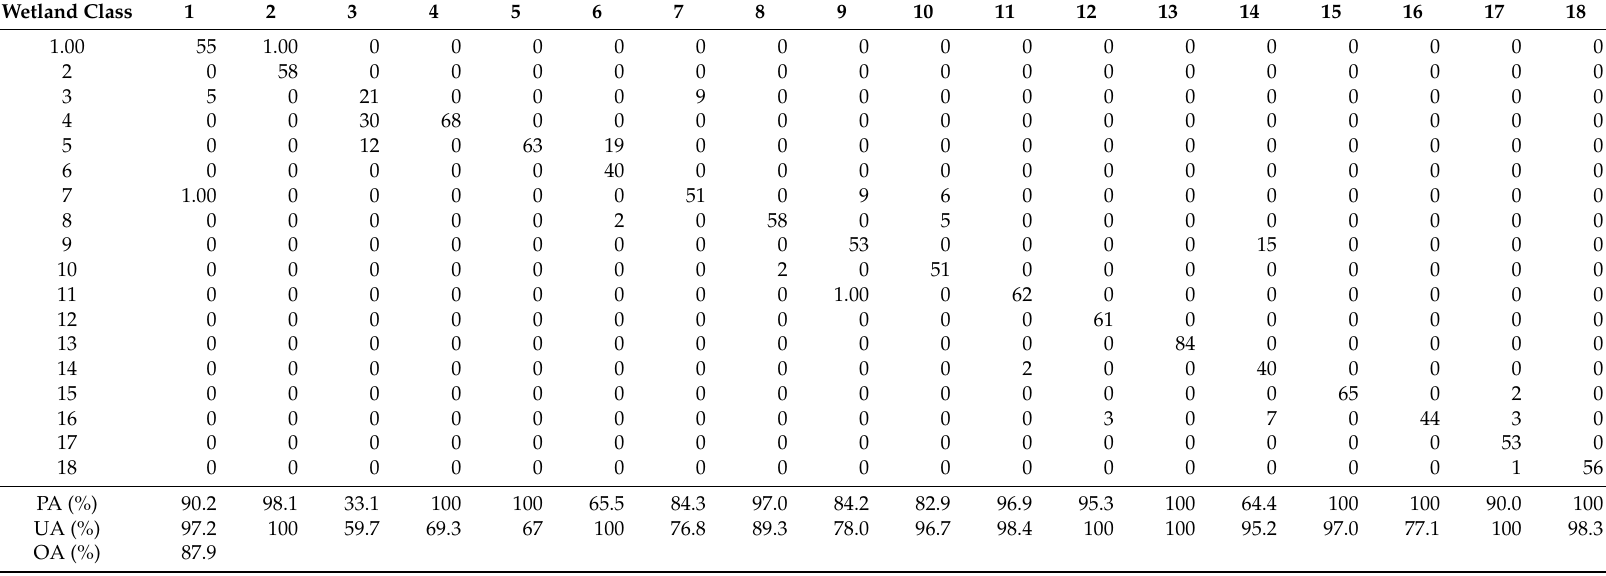
Table 5. Pixel-based random forest classification class confusion matrix (pixel-counts) for genus-level wetland classes and aquatic habitats (three-layer stack). PA, UA, and OA are producer’s, user’s, and overall accuracy, respectively. See the legend in Figure 5a for additional information regarding the wetland class community